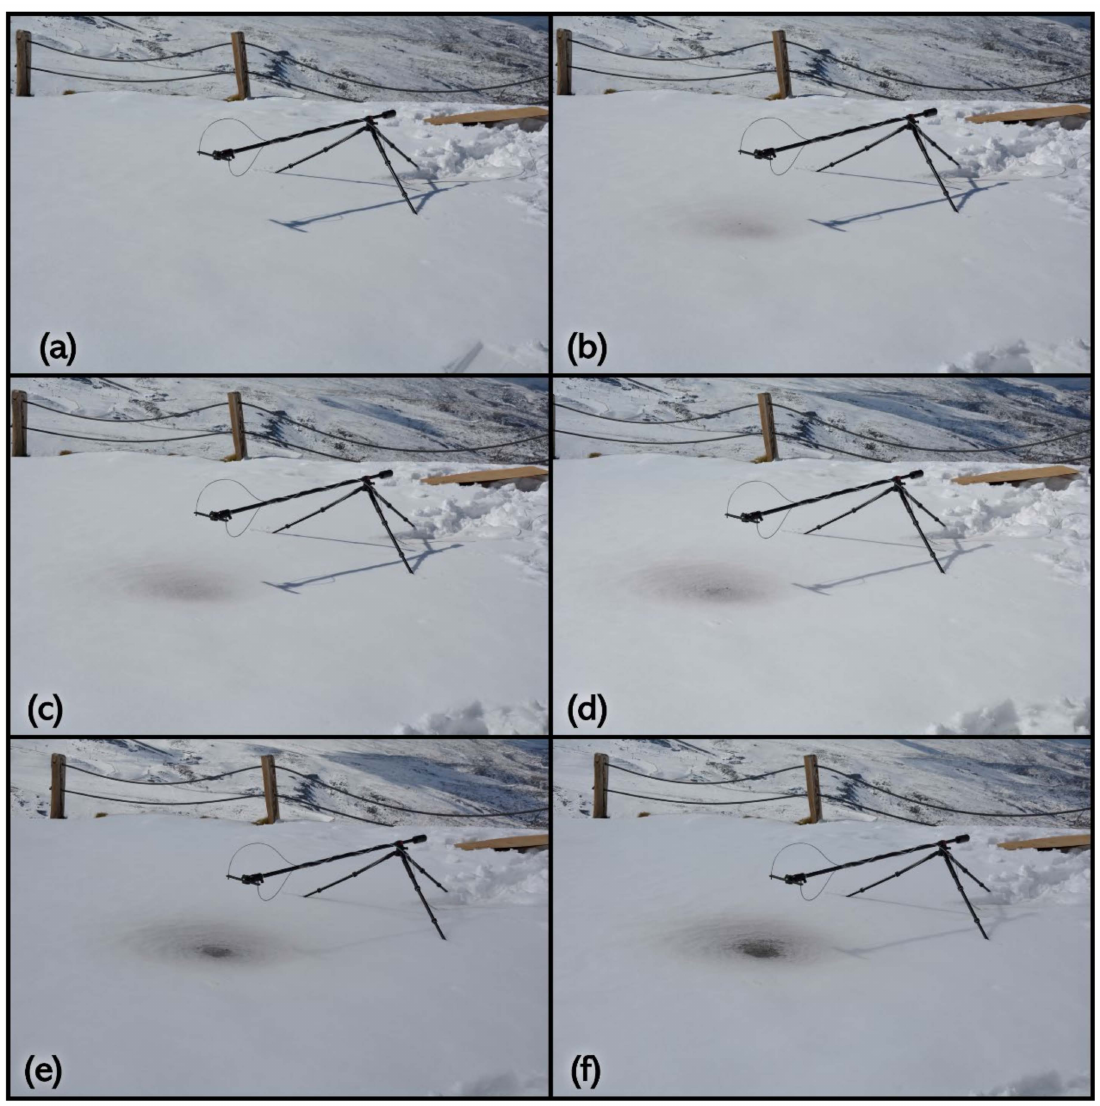
Figure 3. Snow contamination after each acceleration stage: ( a ) 0, ( b ) 30, ( c ) 60, ( d ) 90, ( e ) 120, and ( f ) 150